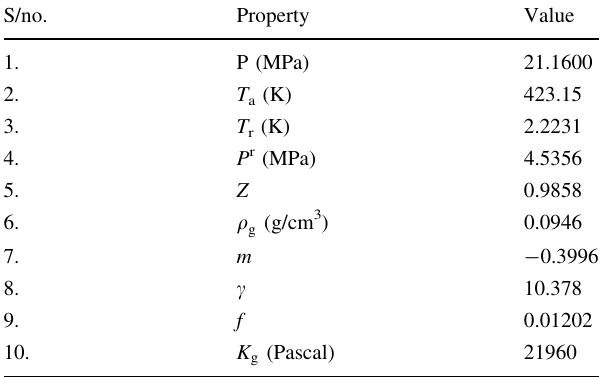
Table 5 Computed parameters of reservoir fully saturated with live oil